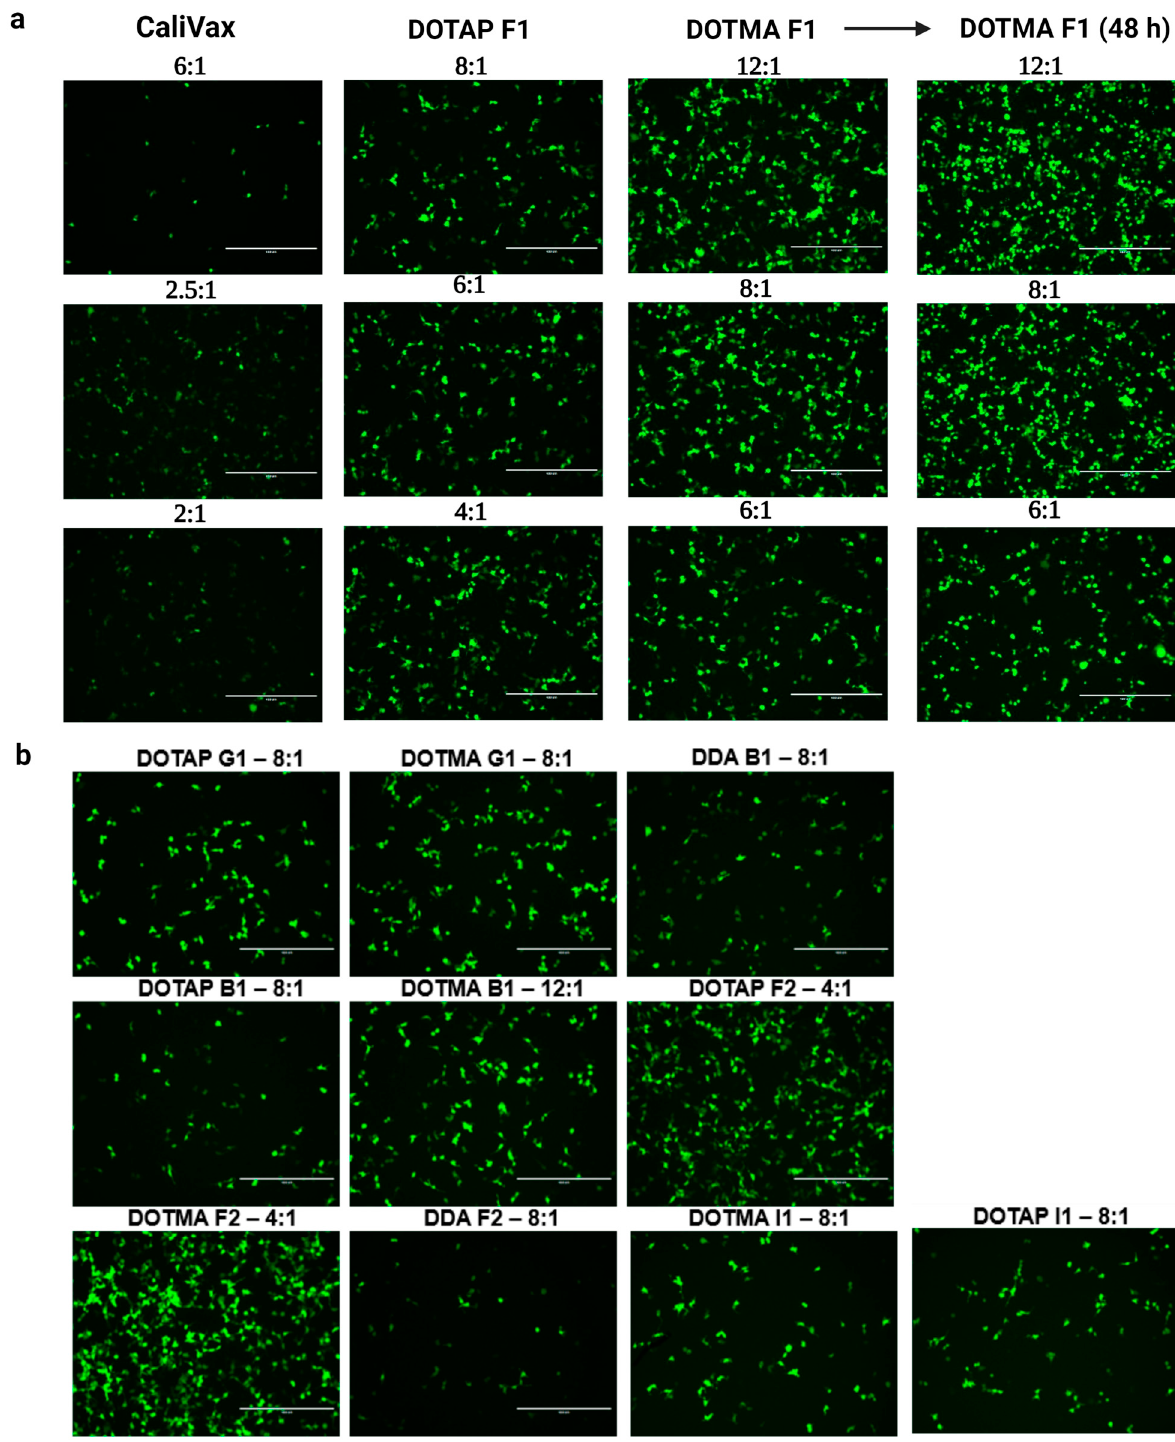
Figure 4. Optimization of saRNA-Ext-cLNPs produced using lipid film hydration. ( a ) Expression of eGFP following transfection of different saRNA-eGFP-cLNP formulations in HEK293 cells showing the effects of N:P ratio on different cLNPs. CaliVax nanoparticles performed best at lower ratios despite their larger size and PDI, whereas DOTAP and DOTMA F1 cLNPs performed optimally at higher N:P ratios. ( b ) A library of LNPs comprising DOTAP, DOTMA and DDA was optimized for delivery of saRNA-eGFP by changing the N:P ratios, showing the importance of optimizing N:P ratio, lipid composition and molar percentages. Scale bars on microscopy images represent 400 µ m. Created using